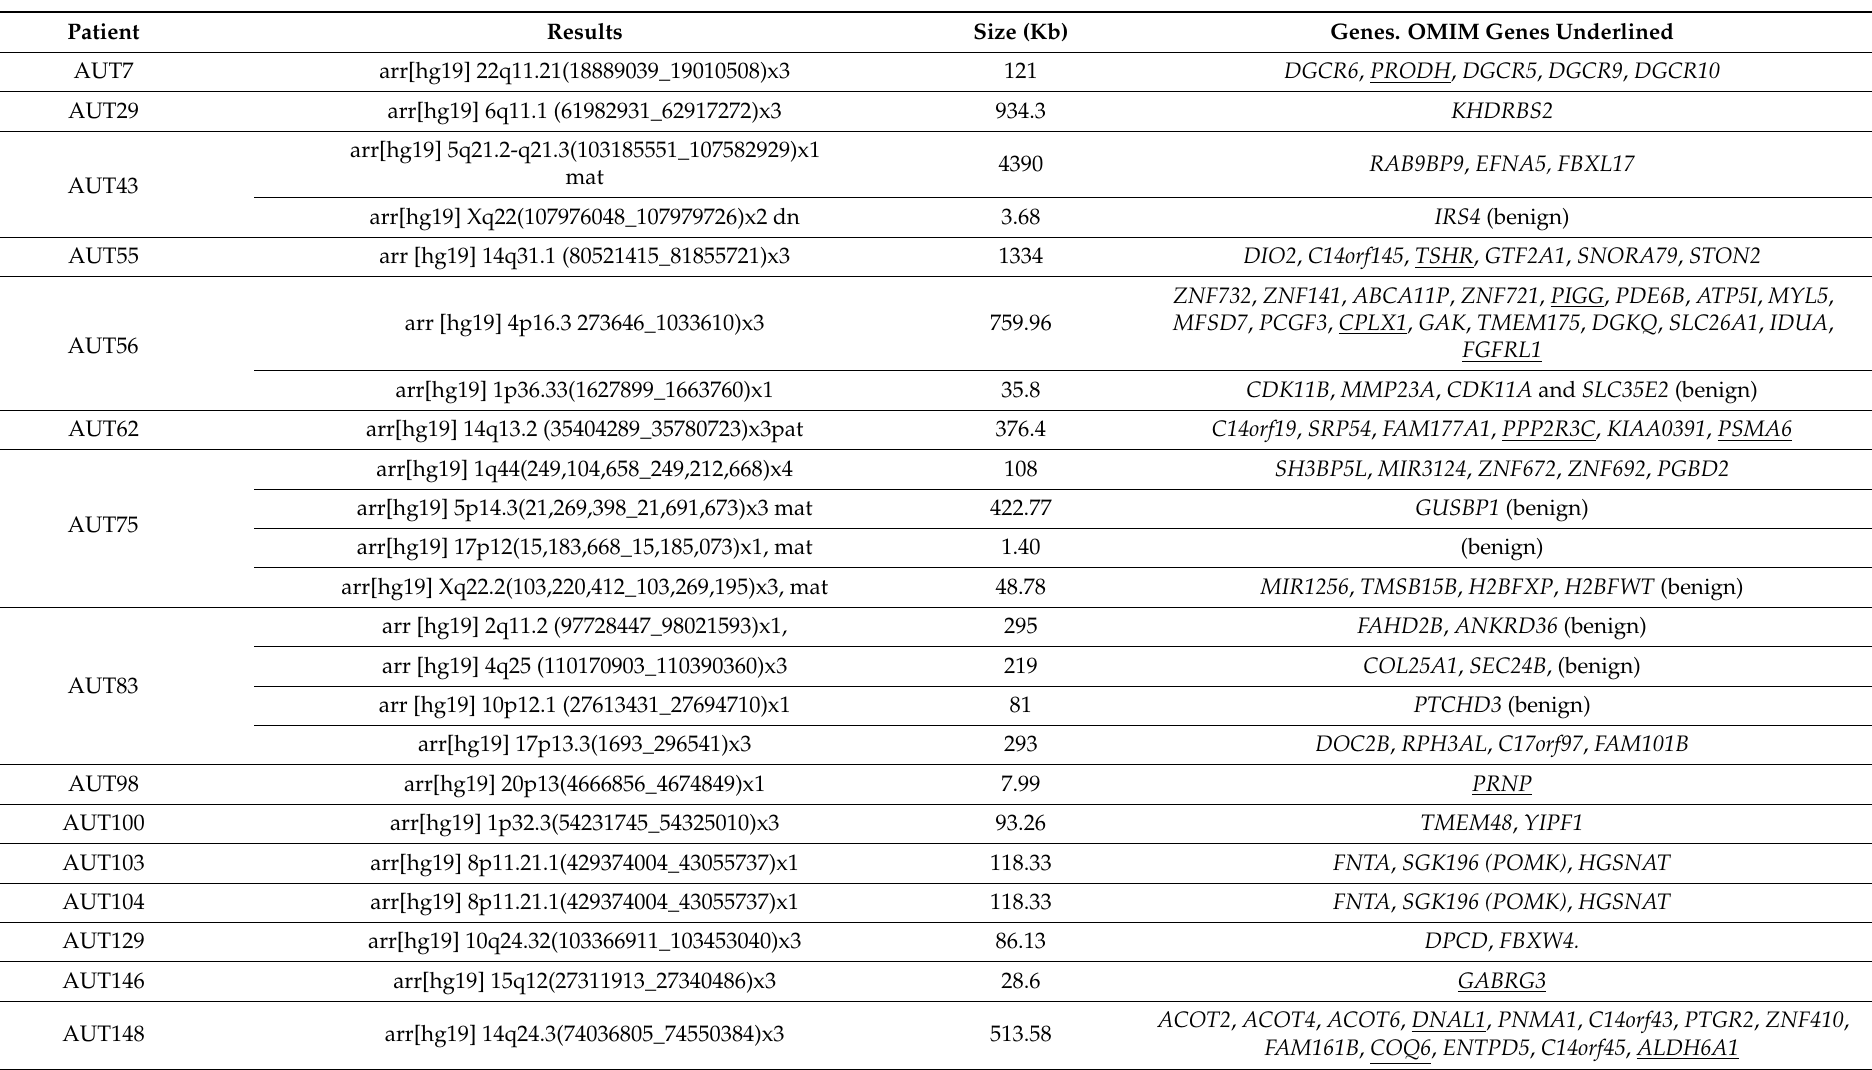
Table 2. Detailed description of the VUS CNVs detected in the